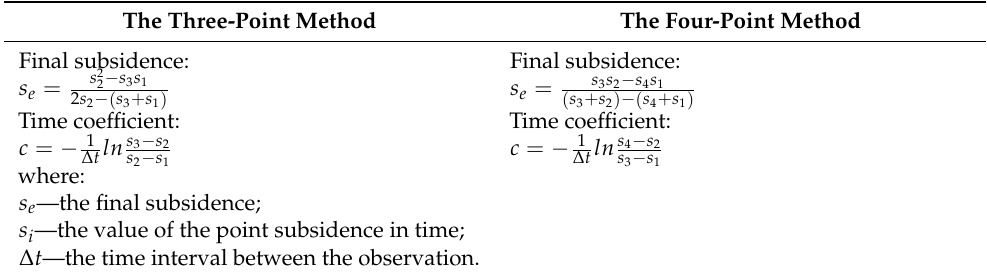
Table 4. Formulas of the three- and four-point method for estimating residual subsidence [31]. The Three-Point Method The Four-Point